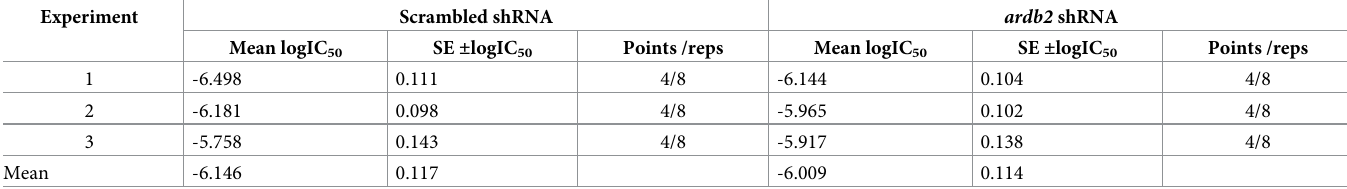
Table 2. IC 50 values for each independent shRNA experiment.